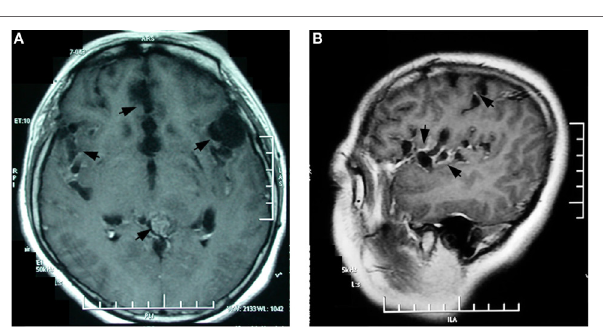
FIGURe 2 | Contrasted brain magnetic resonance imaging 9 months after symptoms onset showed multiple enhanced encapsulated cyst-like lesions in the Sylvian fissure, dilated cortex sulci in the bilateral hippocampus and the medialis of bilateral frontal lobes, and a generally enhanced mass in the quadrigeminal cistern (a) . The sagittal image clearly shows grape-line cysts along the Sylvian fissure (B) .